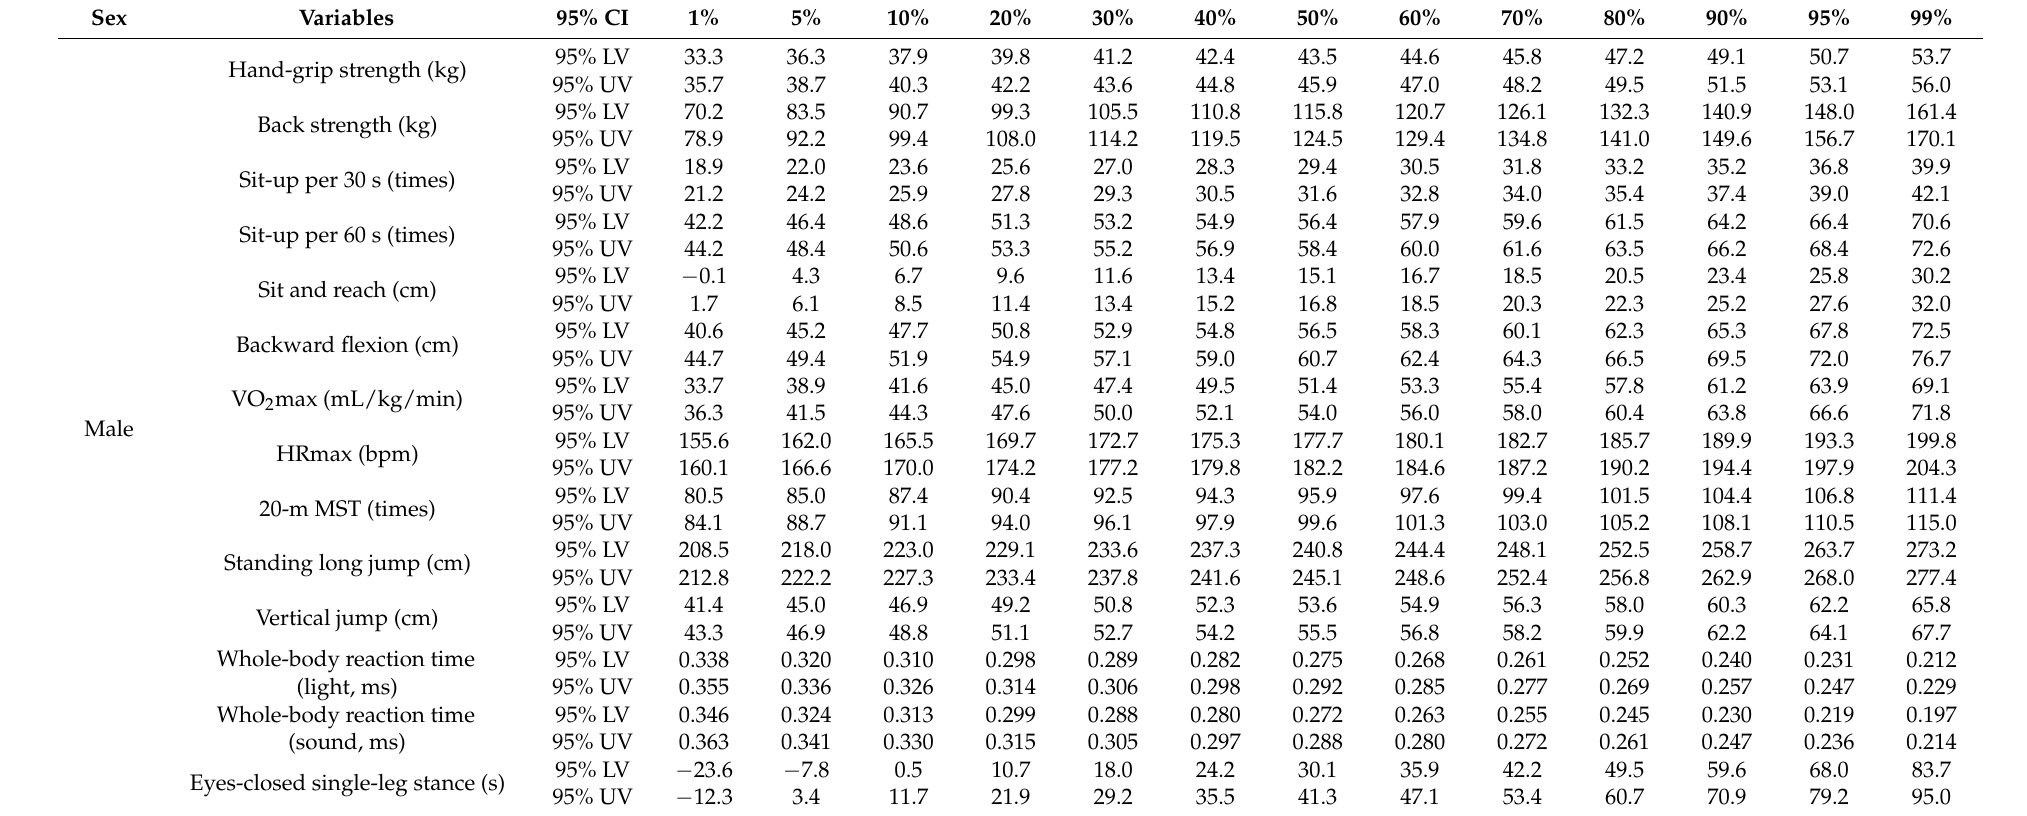
Table 7. Ninety-five percent confidence intervals for the Taekwondo athletes’ physical